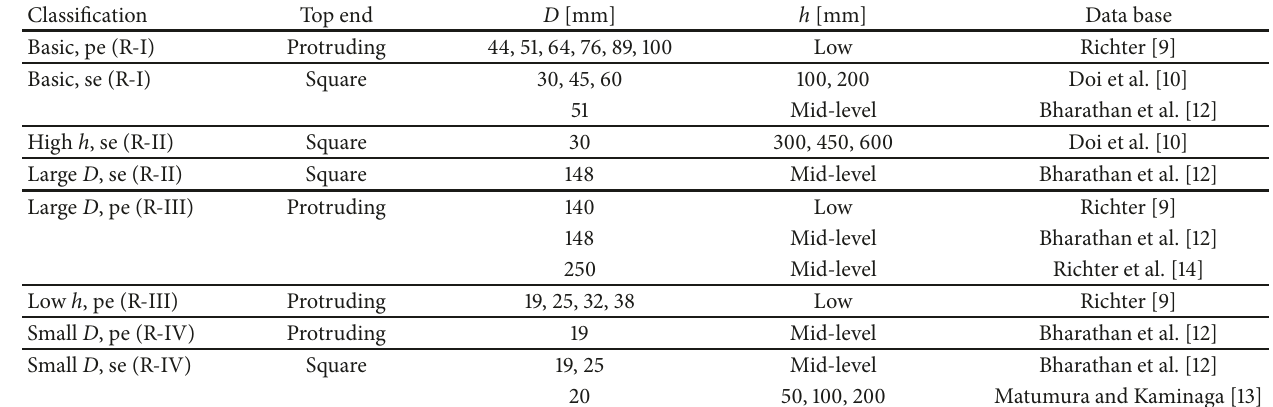
Table 1: Classifications of CCFL at the square top end (Region “R-”: cf. Figure